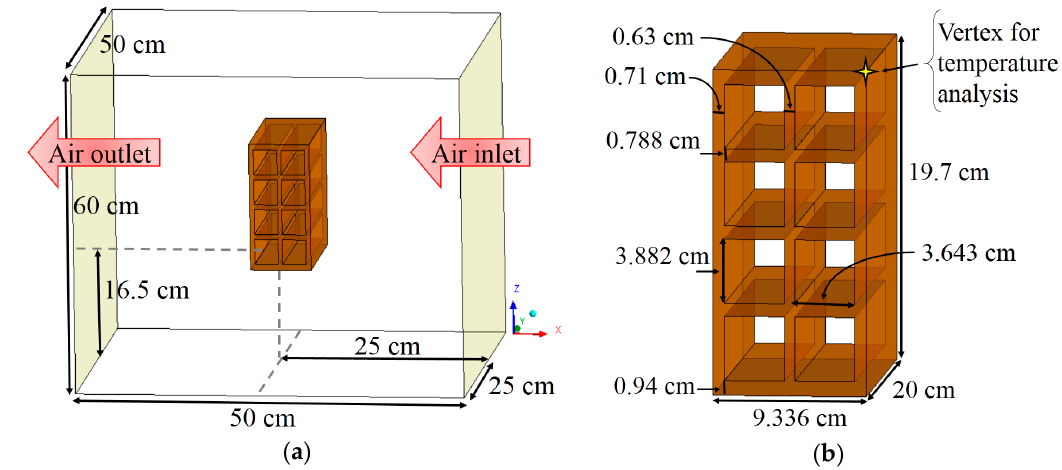
Figure 2. Geometrical representative of the ( a ) oven with the ceramic brick and ( b ) the brick.